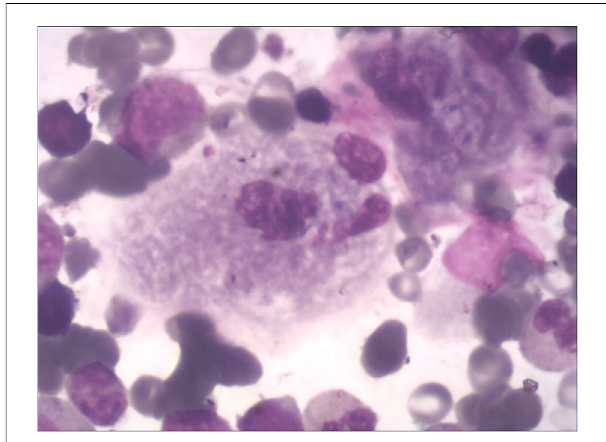
FIGURE 1 Gaucher cells in the bone marrow, with large or giant cell bodies, small nuclei, nuclear deformities, multinucleation, and dense chromatin. The cytoplasm is abundant and arranged in a gray-blue “ onion skin ”